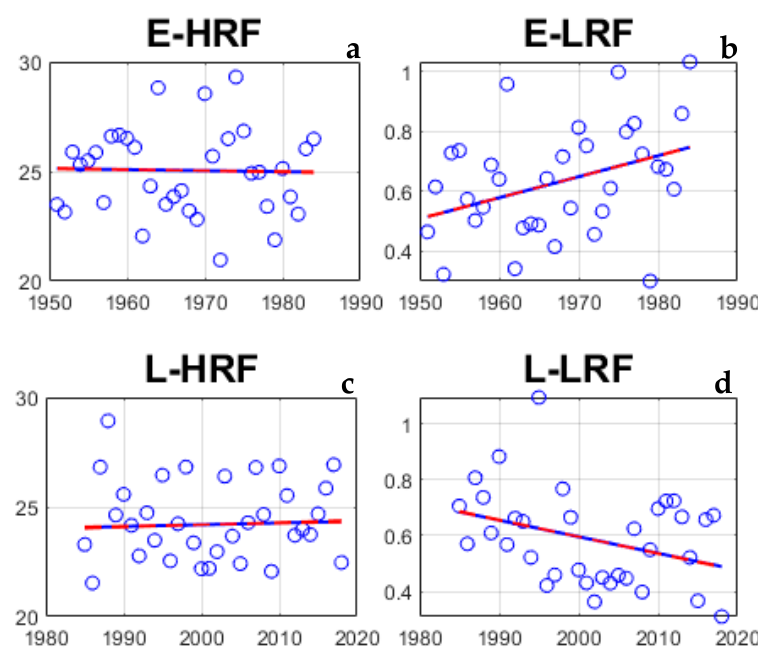
Figure 6. Rainfall magnitude (mm) as detected by (a,c) Extreme/Heavy events (top 90 percentile), and (b,d) Rainfall magnitude as identified by (lowest 10 percentile) over India.